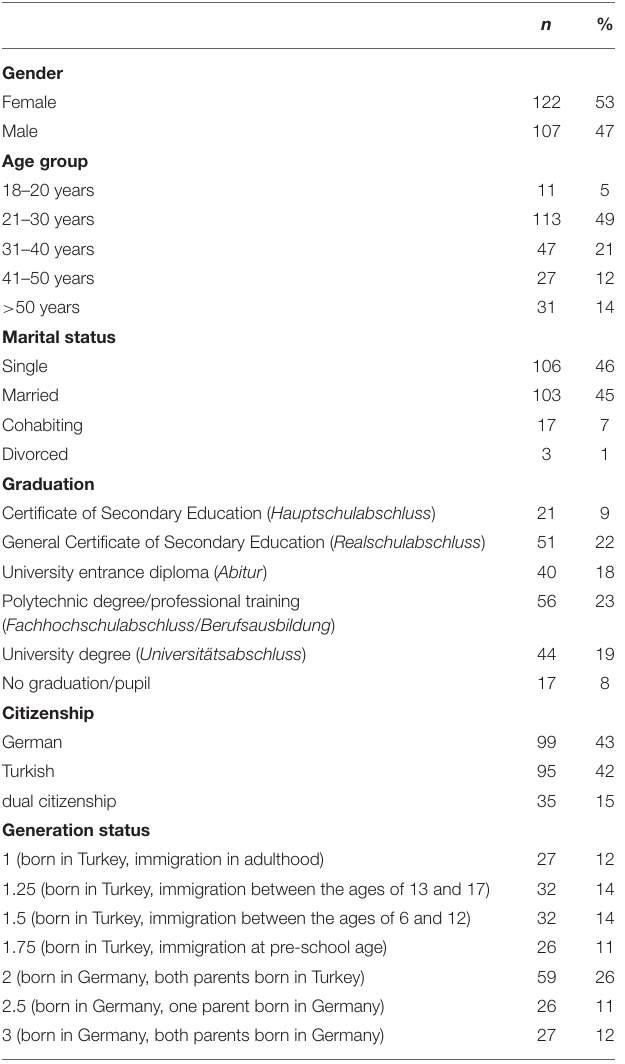
TABLE 1 | Socio-demographic data of the study sample ( N =